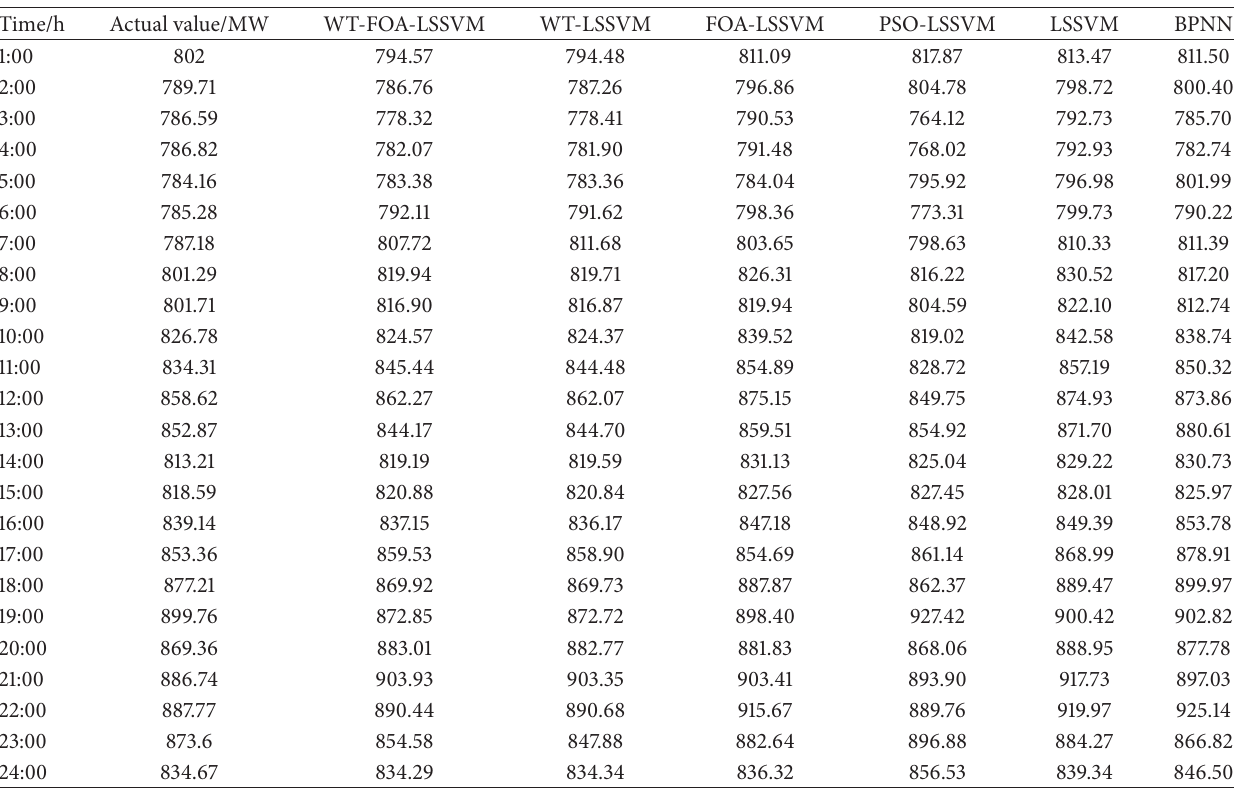
Table 3: Actual load and forecasting results.